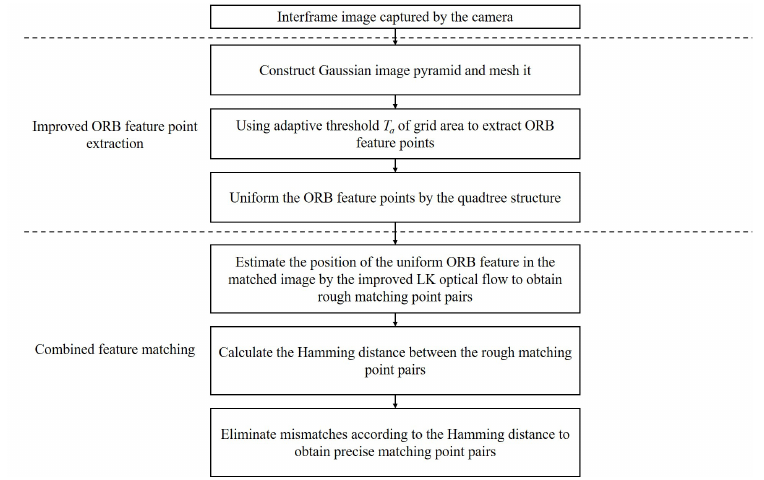
Figure 1. Proposed algorithm